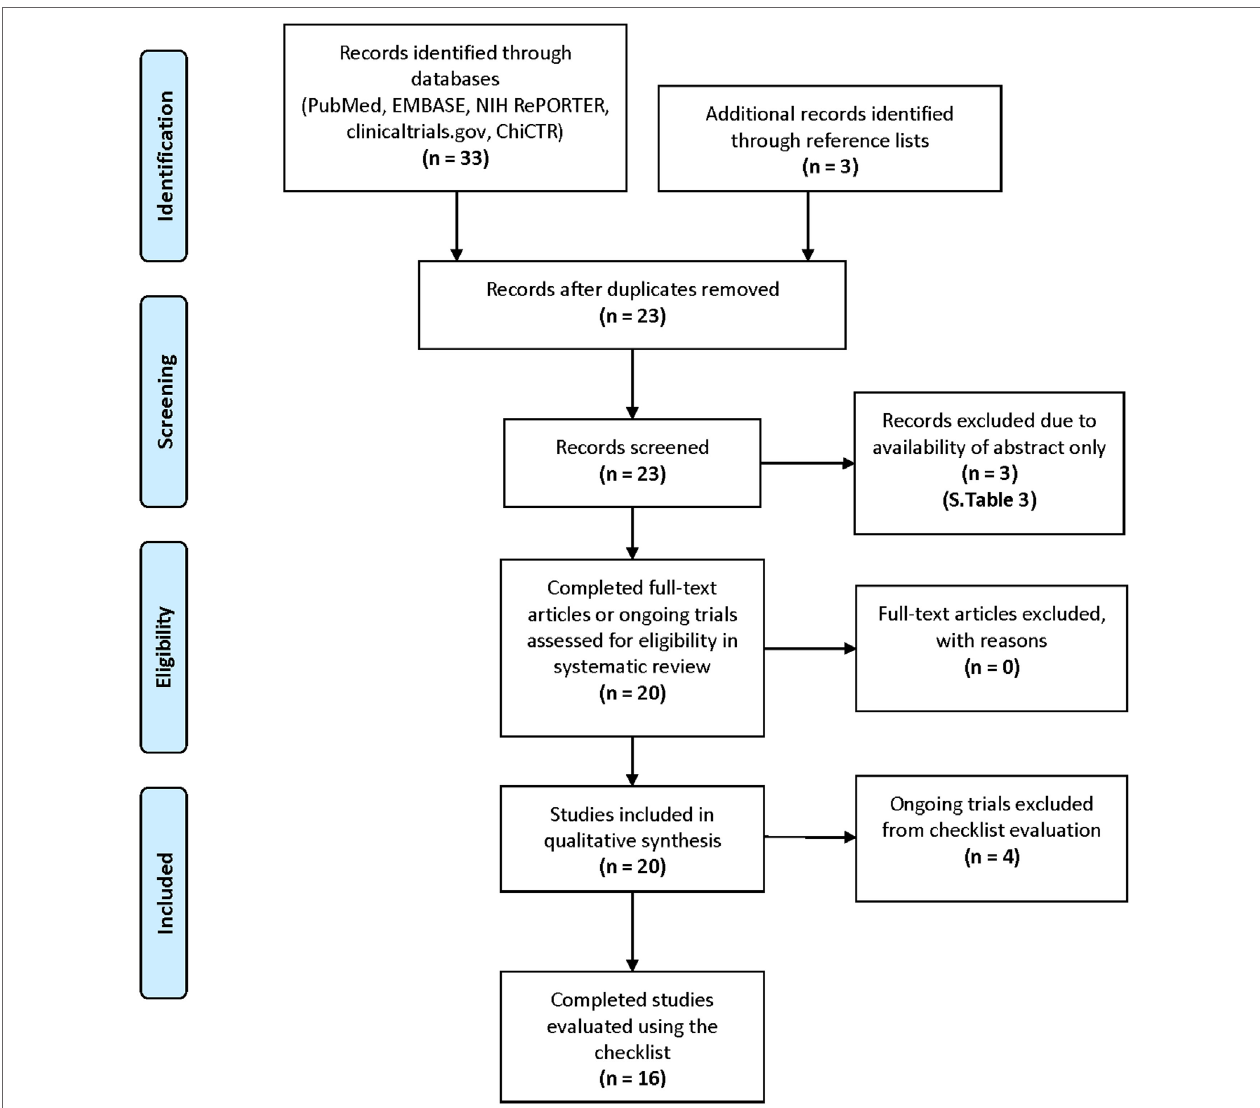
FigURe 1 | Study methodology and search strategy via Preferred Reporting Items for Systematic Reviews and Meta-Analyses guidelines